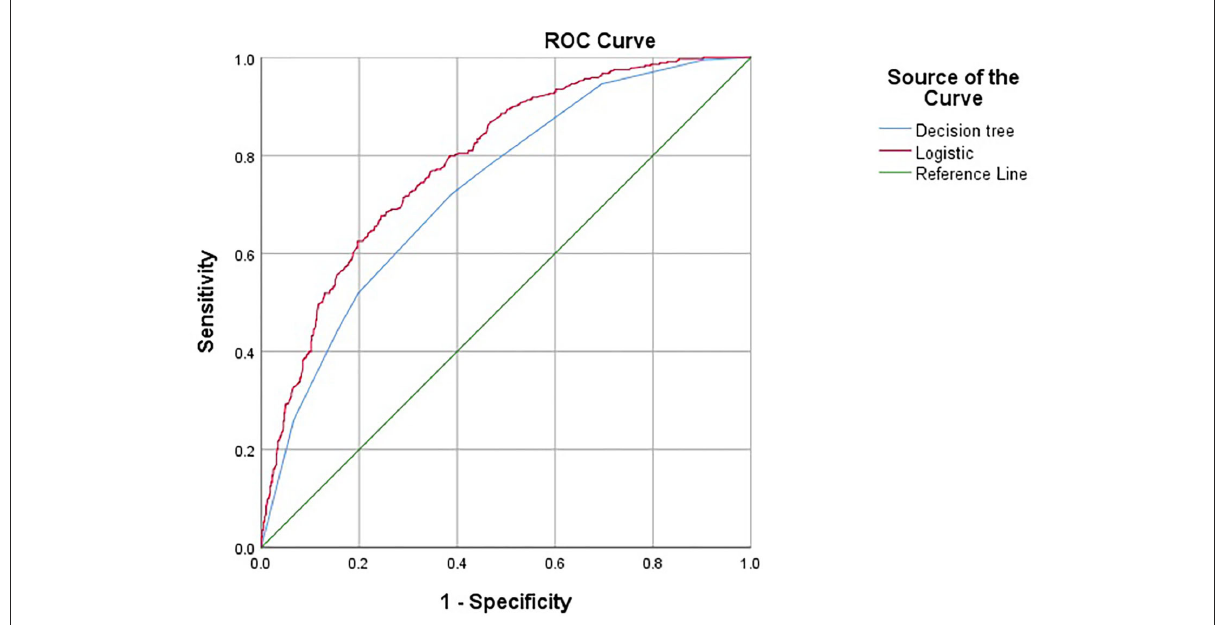
FIGURE4 ROC curve predicted by decision tree and logistic regression